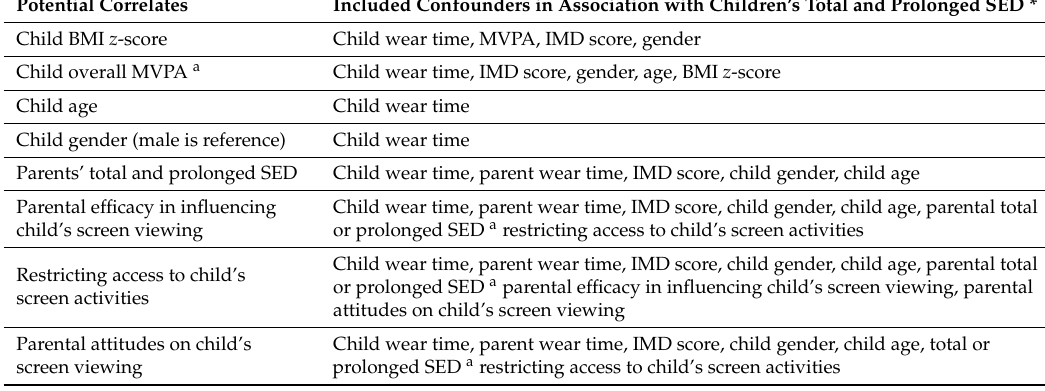
Table 1. Adjustment of associations between child- and parent-related potential correlates with children’s total and prolonged sedentary time